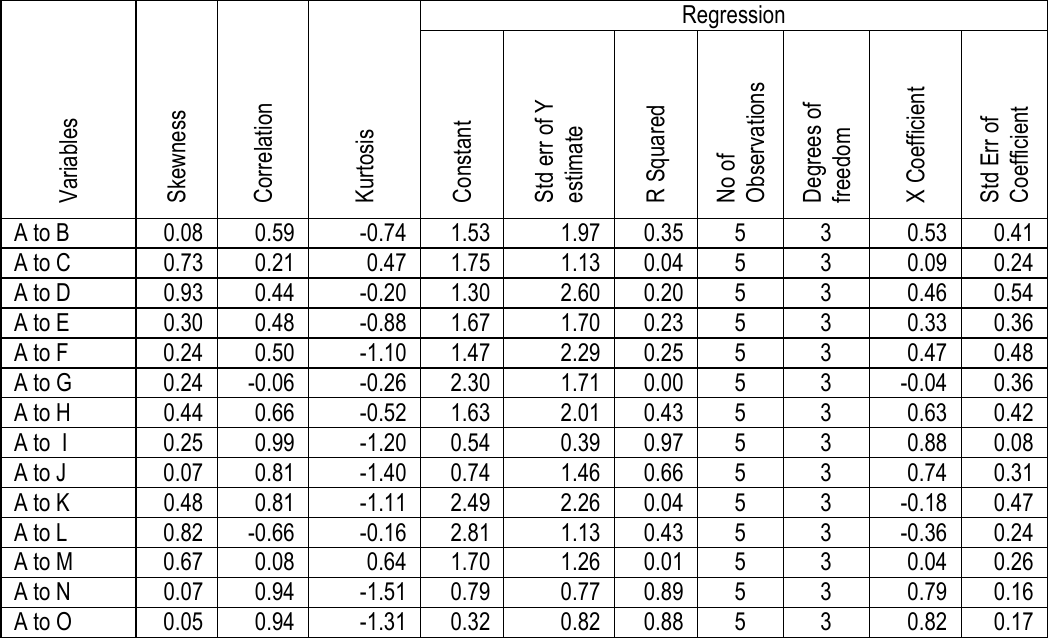
Table 2. Relationship of Educational Administration with other Variables